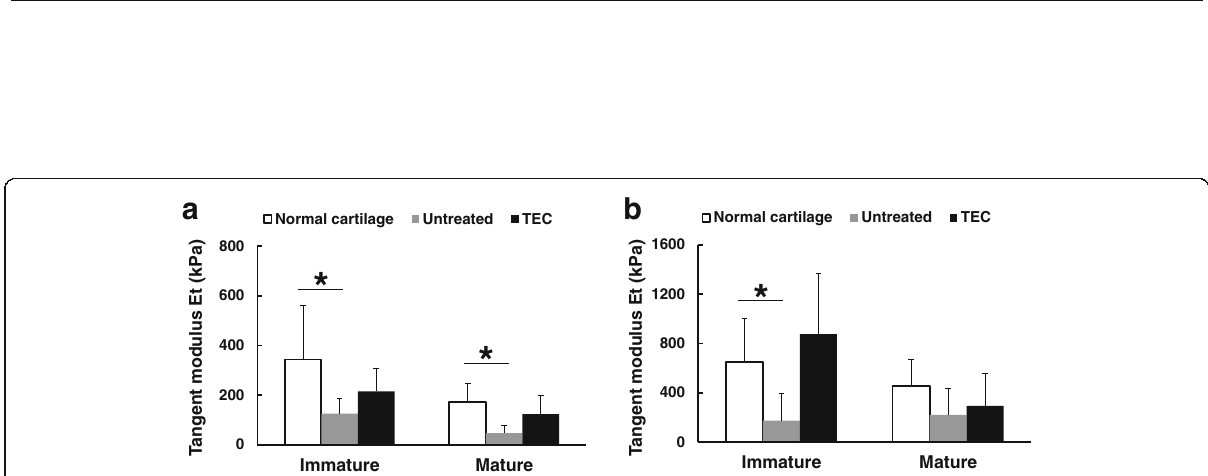
Fig. 4 a Safranin O staining of chondral lesions treated with or without TEC. Bar = 1 mm (upper). Bar = 200 um (lower). Regardless of skeletal maturity, the defects treated with TEC are completely filled with Safranin O positive repair tissue with good tissue integration. b Modified ICRS score for repair cartilage in skeletally immature and mature recipients. The TEC group exhibits significantly higher scores than does the untreated control group, regardless of maturity. *; p < 0.05, **; p < 0.01. Quoted and modified from Shimomura et al. , Biomaterials 2010